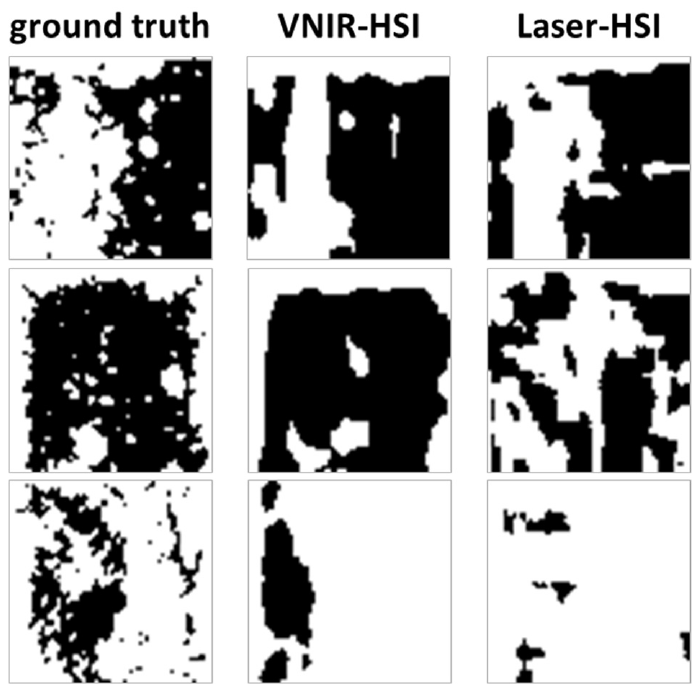
Figure 9. Ground truth and predicted copper coating for three samples from the test dataset for the two HSI methods. White pixel are copper coated and black pixels are not copper coated. The images only show samples with insufficient material removal. For the optimal and the damaging ablation , the complete copper coating was predicted correctly for both HSI methods.